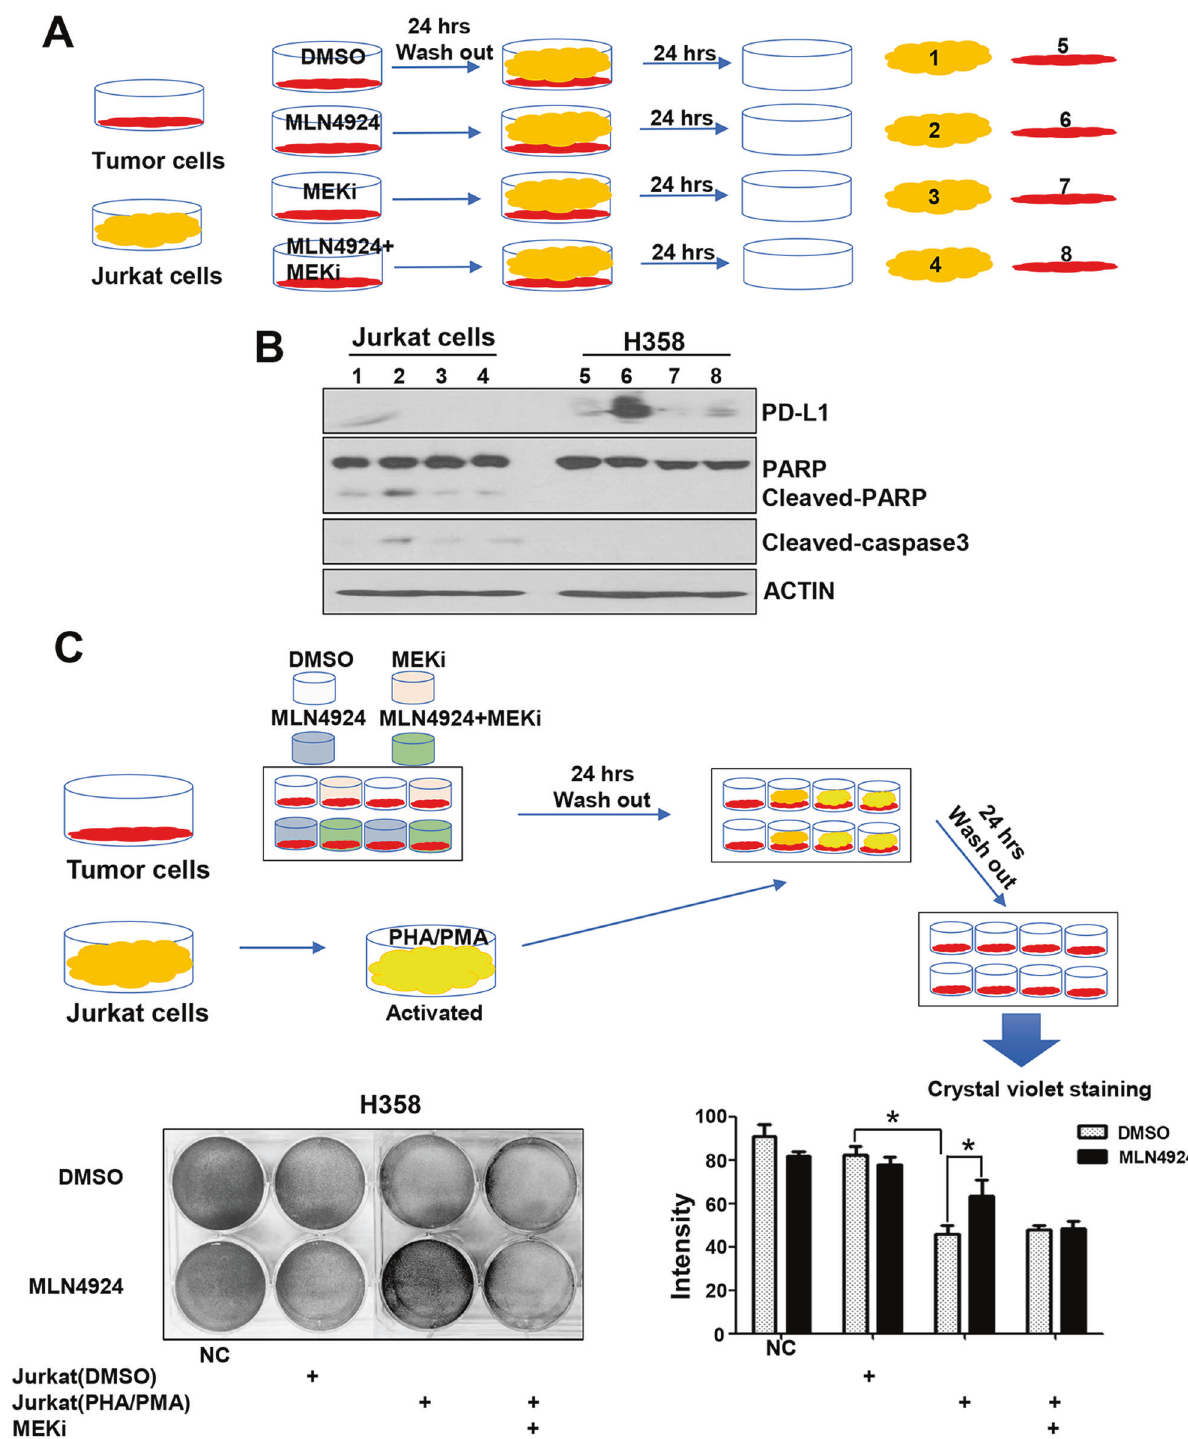
Fig. 5 MEK inhibitor enhances cytotoxic effect of Jurkat cells on MLN4924-pretreated cancer cells. A , B H358 cells were treated with either MLN4924 (0.5 μ M) or indicated inhibitors or both for 24 h, then co-cultured with Jurkat cells for 24 h. The H358 and Jurkat cells were separately harvested for IB with the indicated Abs. C H358 cells were treated with either MLN4924 (0.5 μ M) or indicated inhibitors or both for 24 h, co- cultured with PHA/PMA-activated Jurkat cells for 24 h, followed by crystal violet staining and photography. Shown are mean ± SEM of three independent experiments. p < 0.05 (*), p < 0.01 (**). NC negative control without Jurkat co-culture nor drug treatment. PD-L1 or PD-1 have shown impressive anti-cancer ef fi cacies in the PD-L1 is a major inhibitory checkpoint that negatively regulates treatment of various types of human cancers [37]. PD-L1 the T-cell functions [15, 35, 36]. Cancer cells with high expression upregulation by cancer cells in response to drug exposure is of PD-L1 evade T-cell anti-cancer immunity through the PD-L1/ likely to be a general phenomenon and is part of a pro-survival PD-1 blocking axis. As such, the therapeutic antibodies against Cell Death and Disease (2022)